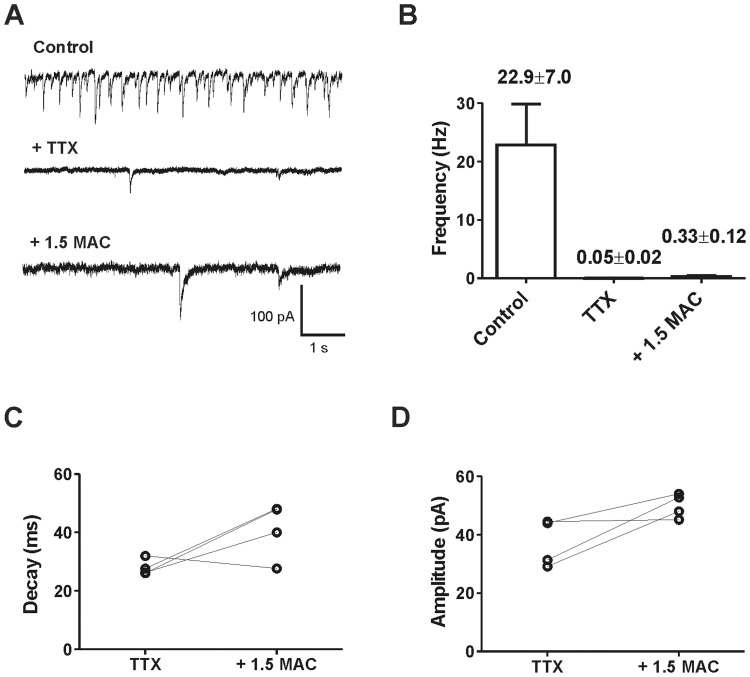
Sevoflurane increased the amplitude and event rate of GABAergic miniature IPSCs.(A) Representative recording of spontaneous GABAA receptor-mediated IPSCs (upper trace). To focus on postsynaptic sevoflurane effects miniature IPSCs (mIPSCs) were isolated by adding 1 µM tetrodotoxin (TTX, middle trace). Subsequently, 1.5 MAC sevoflurane was applied (lower trace). (B) Pooled data revealed an event rate of 22.9±7.0 Hz for control condition (n = 9). In 5 out of 9 experiments, no single mIPSC could be detected after TTX application. In 4 experiments, the frequency of mIPSC was less than 99% compared to the initial spontaneous event rate without TTX (mIPSC frequency 0.046±0.018 Hz (n = 4). Additional application of 1.5 MAC sevoflurane increased the frequency of mIPSC events to 0.33±0.12 Hz (n = 4). (C) Sevoflurane prolonged the mean decay time of mIPSCs (TTX condition 28.0±1.4 ms vs. 40.9±4.8 ms sevoflurane, n = 4, p<0.05). (D) Additionally, the mean of mIPSC amplitudes augmented from 37.3±4.1 pA (TTX condition) to 50.0±2.1 pA (n = 4, p<0.05).